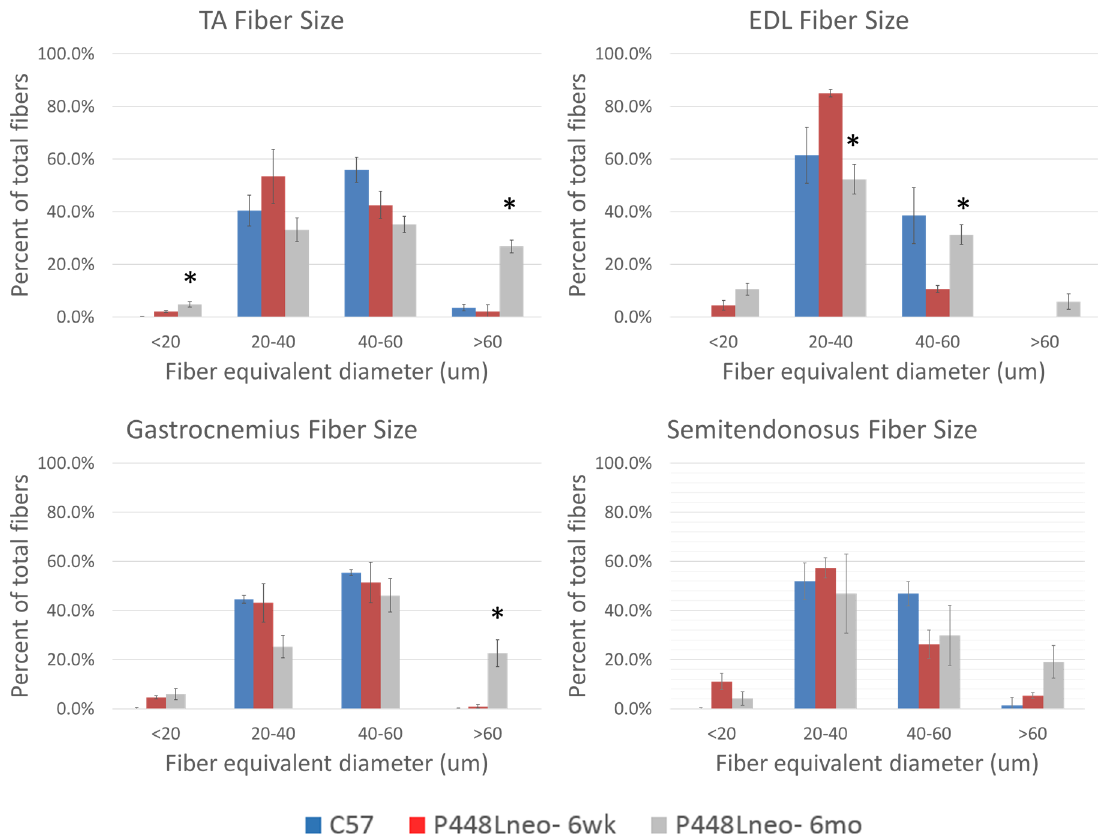
Fig 3. Increase in fiber size of hindlimb muscles of P448Lneo- mutant mouse. A clear increase in fiber size of the TA, EDL and gastrocnemius is seen from 6 weeks to 6 months of age with only a slight increase in the semitendinosus. However, a larger population of small fibers, < 20 micron diameter, is seen in the EDL and gastrocnemius. Significant difference between 6 weeks and 6 months noted with (cid:3) . Significance determined as p <